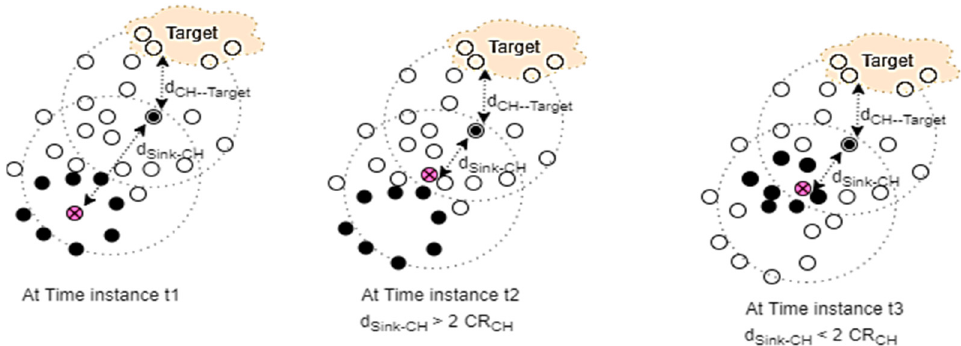
Figure 6. Communication between the mobile sink node and the CH at different instances.